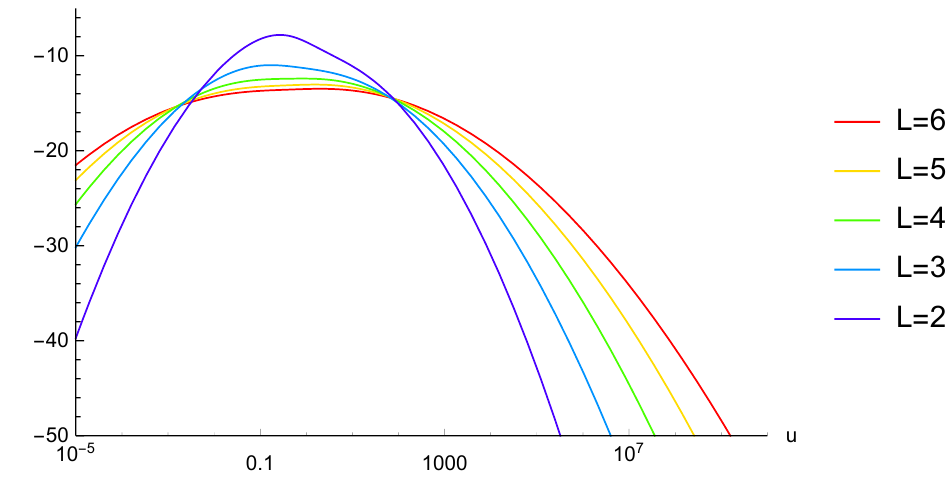
Figure 4 . E ( L ) ( u; 1 ; 1) =E ( L (cid:0) 1) ( u; 1 ; 1) evaluated at successive loop orders.